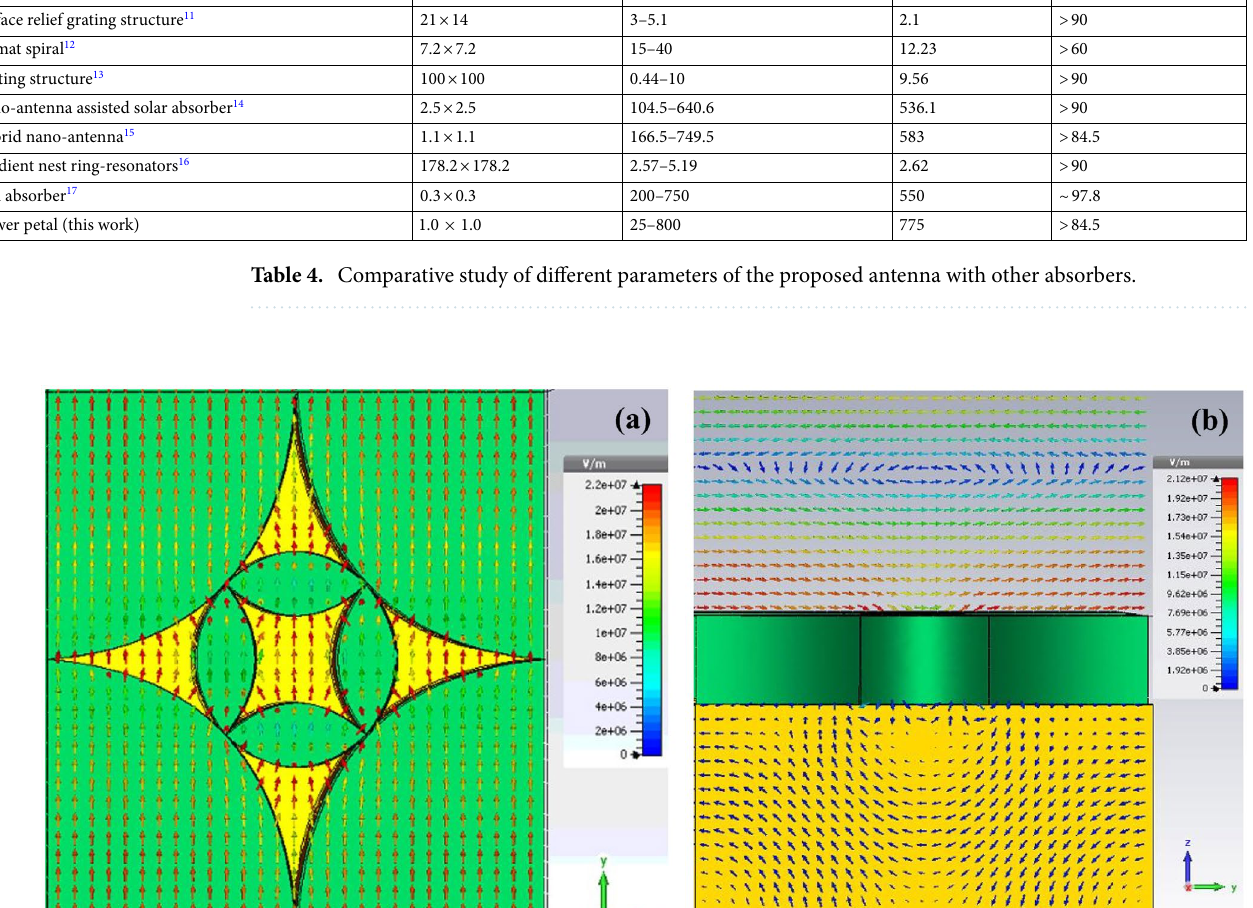
For practical applications, polarization-independent performance and a wide-angle incident wave are vitally important since, in some situations the incident wave is obliquely incident to the device. Therefore, polarization insensitivity of the proposed antenna was tested for normal as well as oblique incidences. Figure 7a,b show the absorption spectra of the proposed unit cell antenna under different incident angles (θ varies) up to 75° in the tread of 15° for both TE and TM mode polarizations. From the figures, it is seen that the antenna has no appar- ent change of absorption performance over the operating frequency ranges, maintained the average absorption above 82.7% for TE and 83.5% for TM mode under oblique incidence of incoming waves up to 45°. However, the absorption performance degrades above 45° for both mode of polarizations, which might be due to reflection and interference of the incoming waves. This finding indicates that the structure is polarization insensitive up to 45° for both the TE and TM modes. The unique mechanism of coupling between relevant electric and magnetic resonances and free-space incident light is attributed with the angle-independent absorption. In addition, to demonstrate the polarization insensitivity under normal incidence ( θ = 0 °) of plane waves, we also investigated